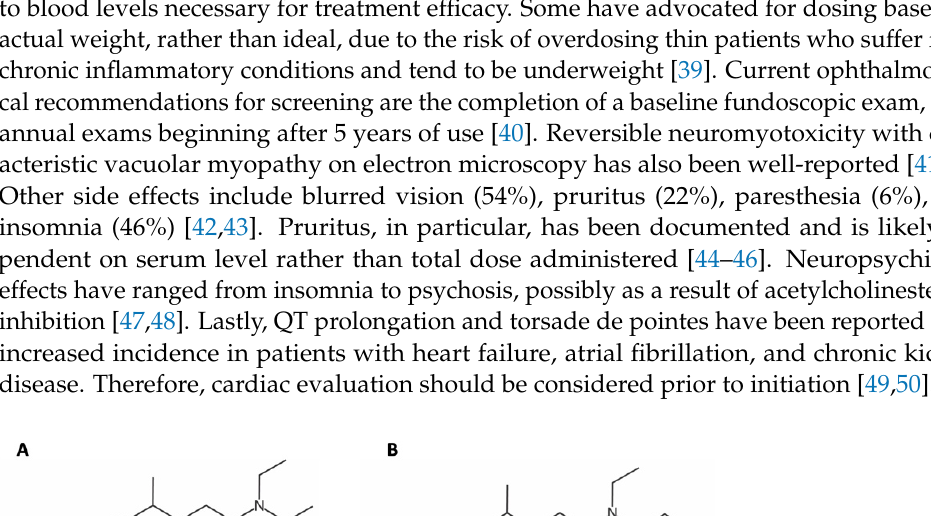
Figure 3. The impact of chloroquine and hydroxychloroquine on endosomal and lysosomal func- tion. ( A ) Endosomal internalization of ligands allows for cell signaling. This process requires an acidic environment which CQ inhibits, preventing downstream signaling through endocytic TLRs and the NOX complex. ( B ) CQ induces lysosomal membrane permeabilization, leading to cell death. ( C ) CQ prevents lysosomes from merging with autophagosomes in the process of autophagy through lysosomal alkalinization.